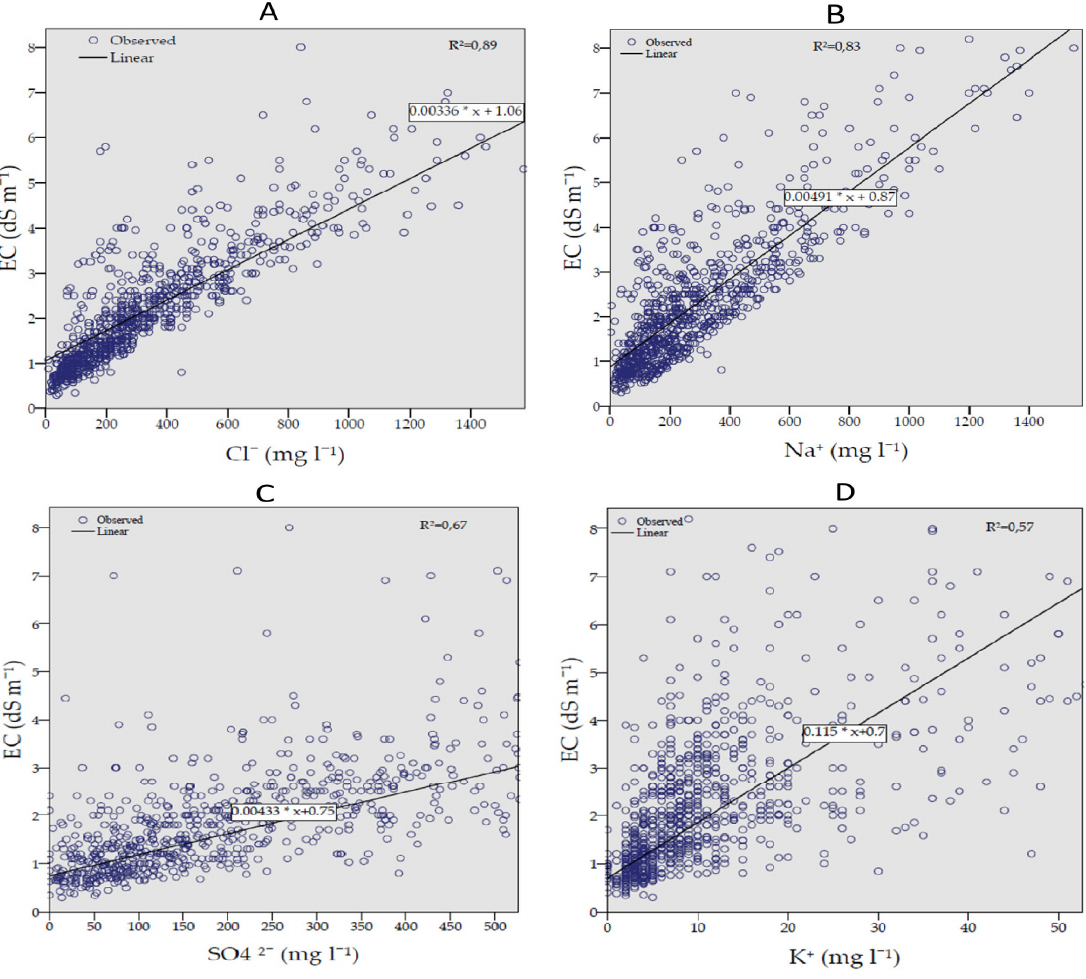
Figure 4. Linear regression modeling and coefficients (R 2 ) between different ions (Chloride, Cl − , ( A ); Sodium, Na + , ( B ); Sulphate, SO 42 − , ( C ); Potassium, K + , ( D )) and water electrical conductivity (EC).